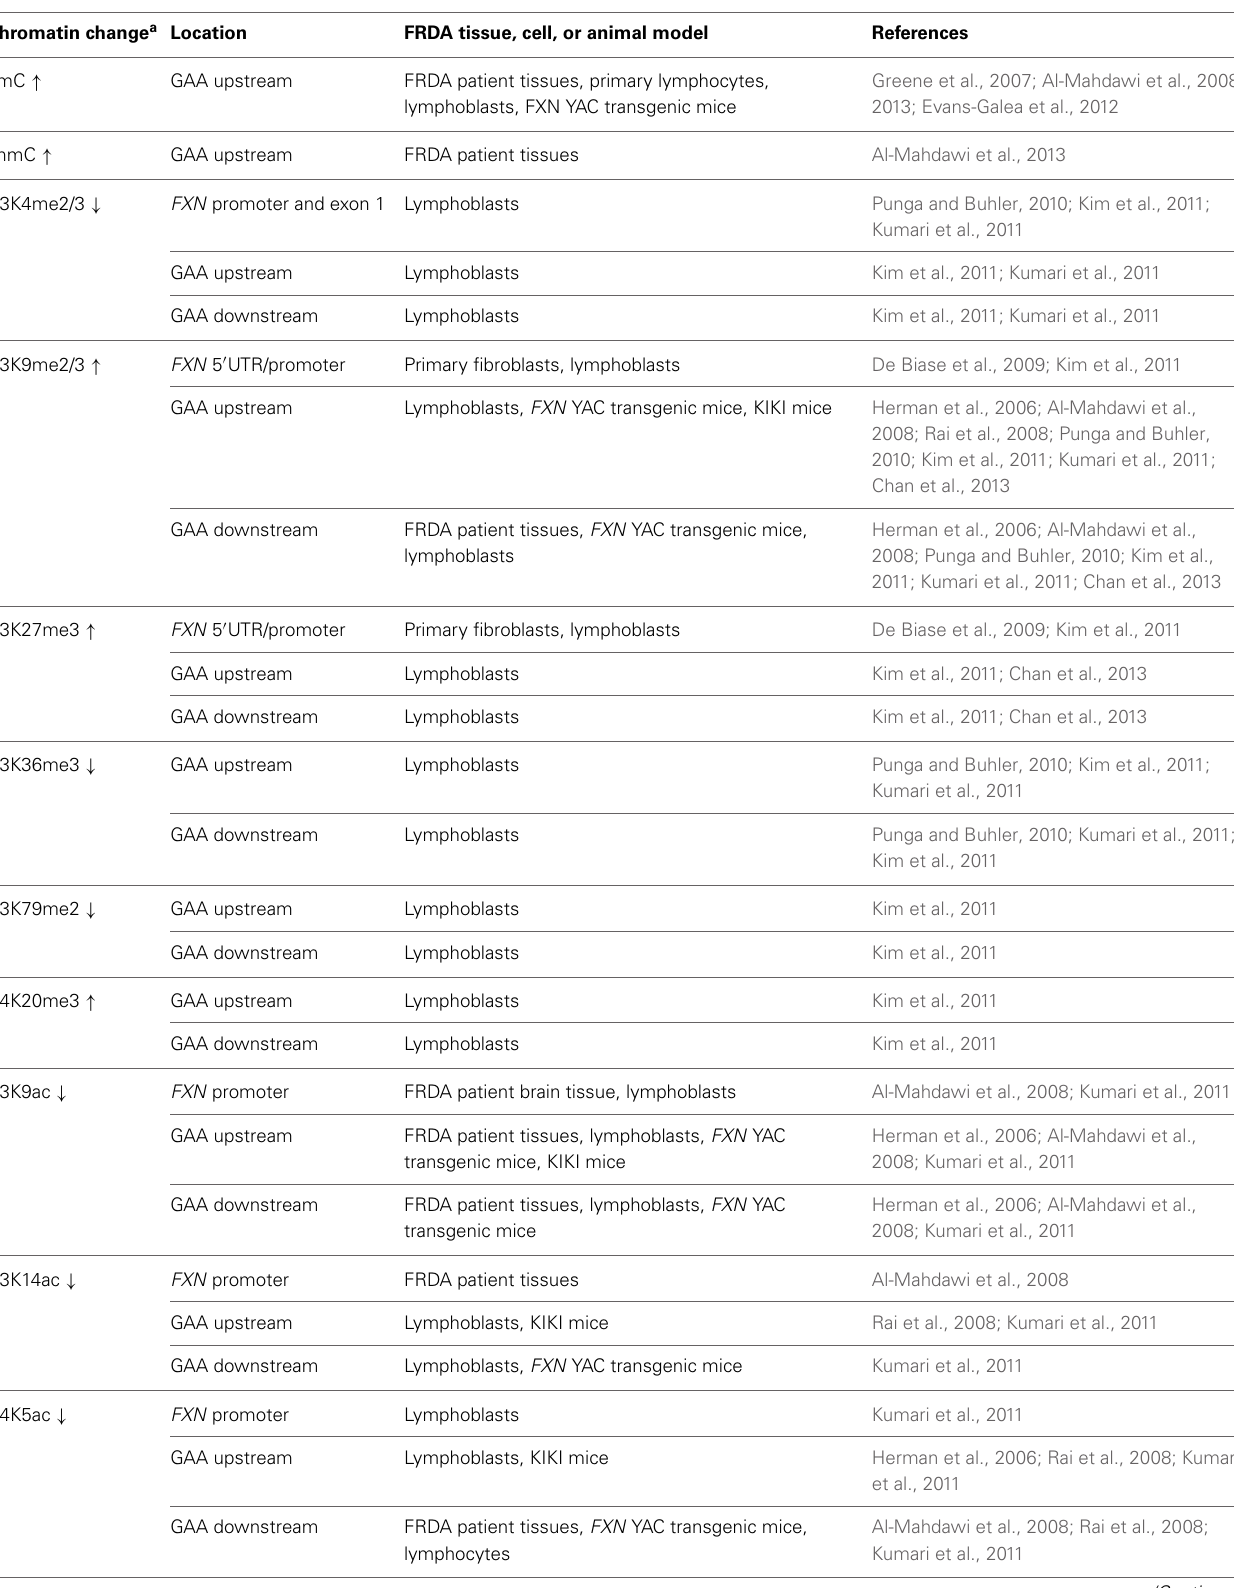
Table 1 | Epigenetic changes in tissues, cells, and animal models of